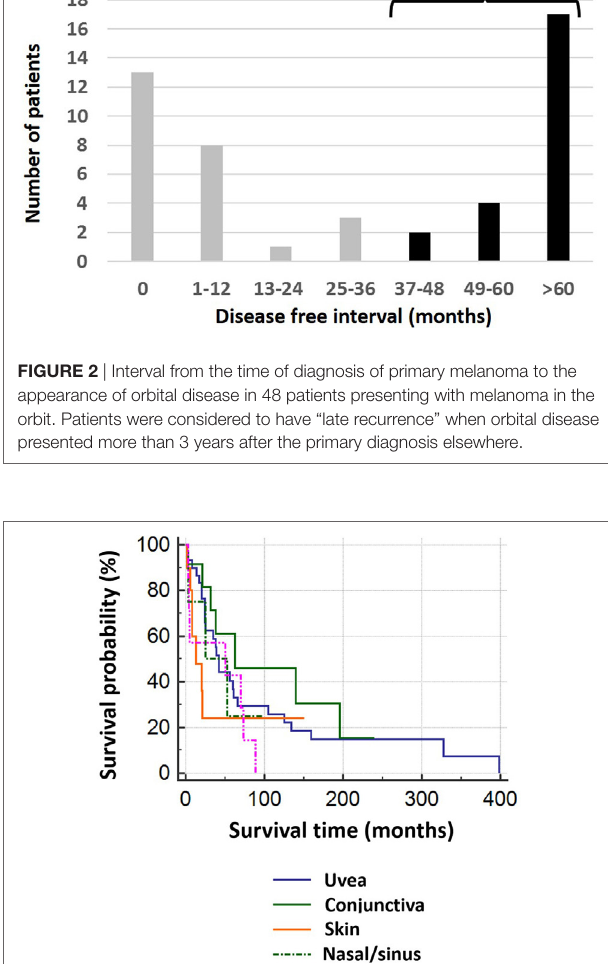
FigUre 1 | Sites of primary origin for malignant melanomas for 89 patients presenting with melanoma in the orbit.